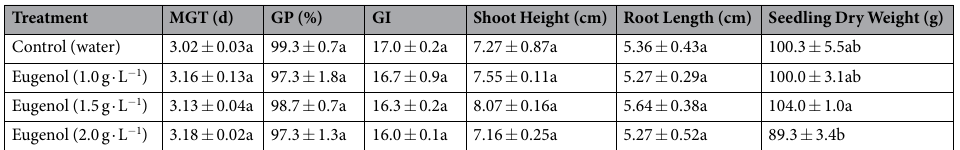
Table 2. Effects of different concentrations of eugenol on the germination and seedling growth of the freshly harvested hybrid rice seeds of Qian You 1 from the field trial. Each value represents the mean (n = 3); small letters following the values within each column indicated significant differences ( α = 0.05, LSD) among control and eugenol